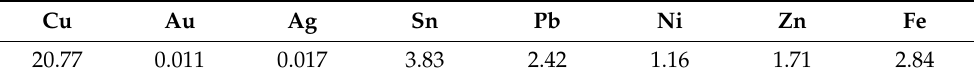
Table 8. Metallic composition (wt.%) of WPCBs feed into the recycling plant.